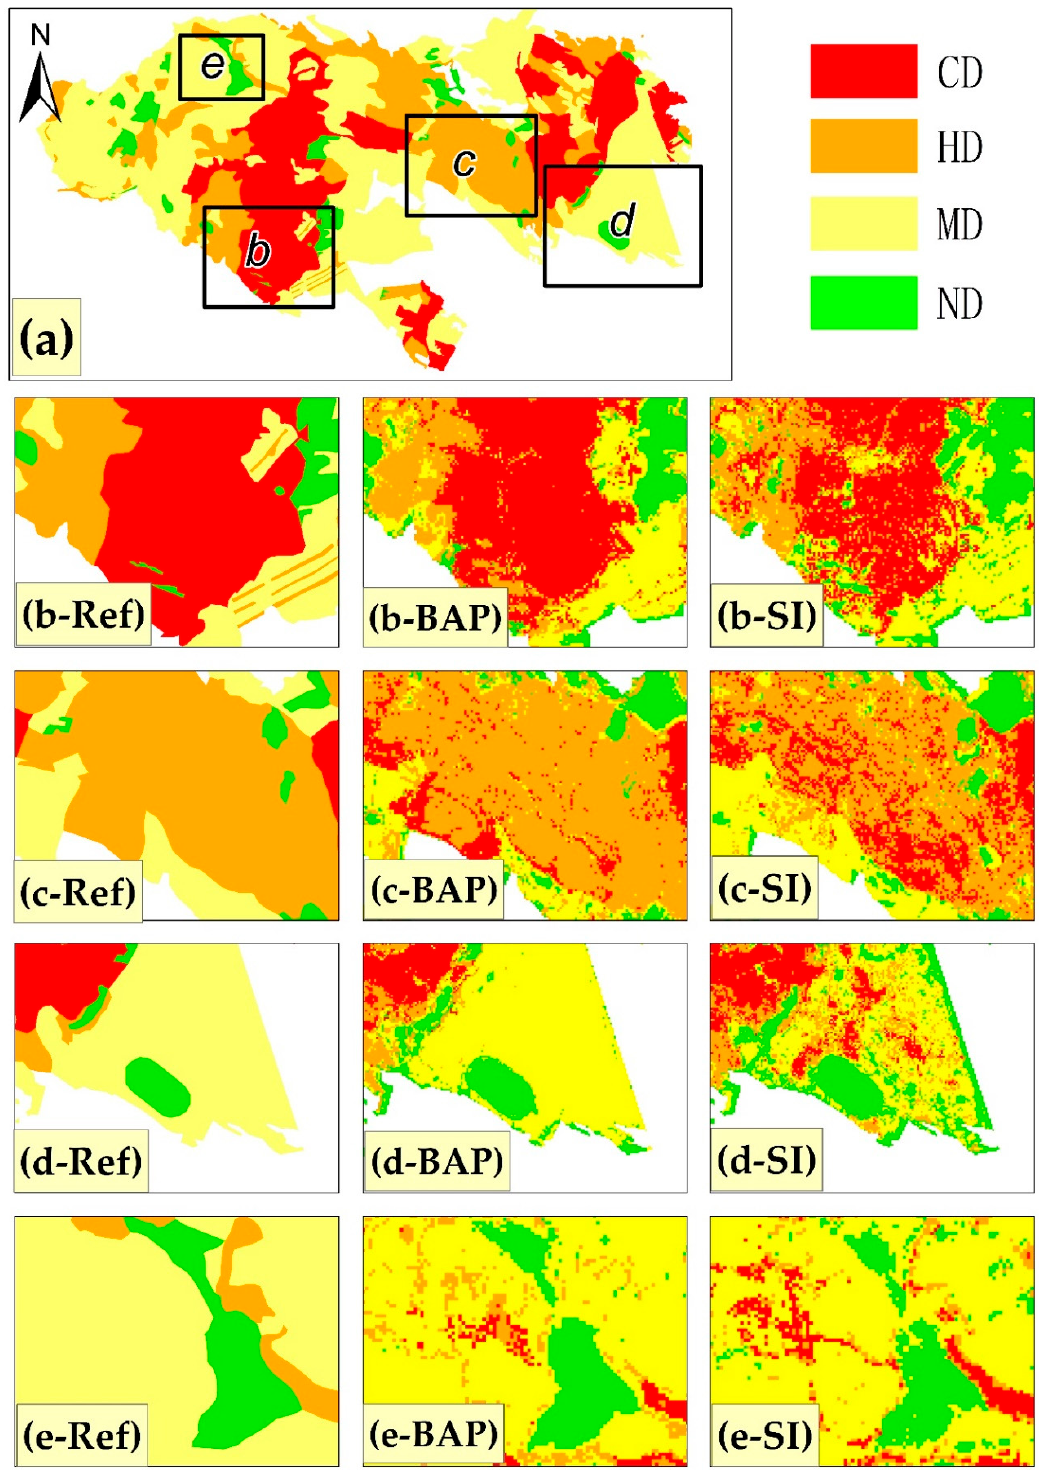
Figure 7. Detailed display of EMSR171 fire mapping results: ( a ) fire severity reference map; ( b ) De- tailed display of CD class; ( c ) HD class; ( d ) MD class; ( e ) ND class. Ref: reference map; BAP: Fire severity mapping generated by BAP method; SI: Fire severity mapping generated by SI method.